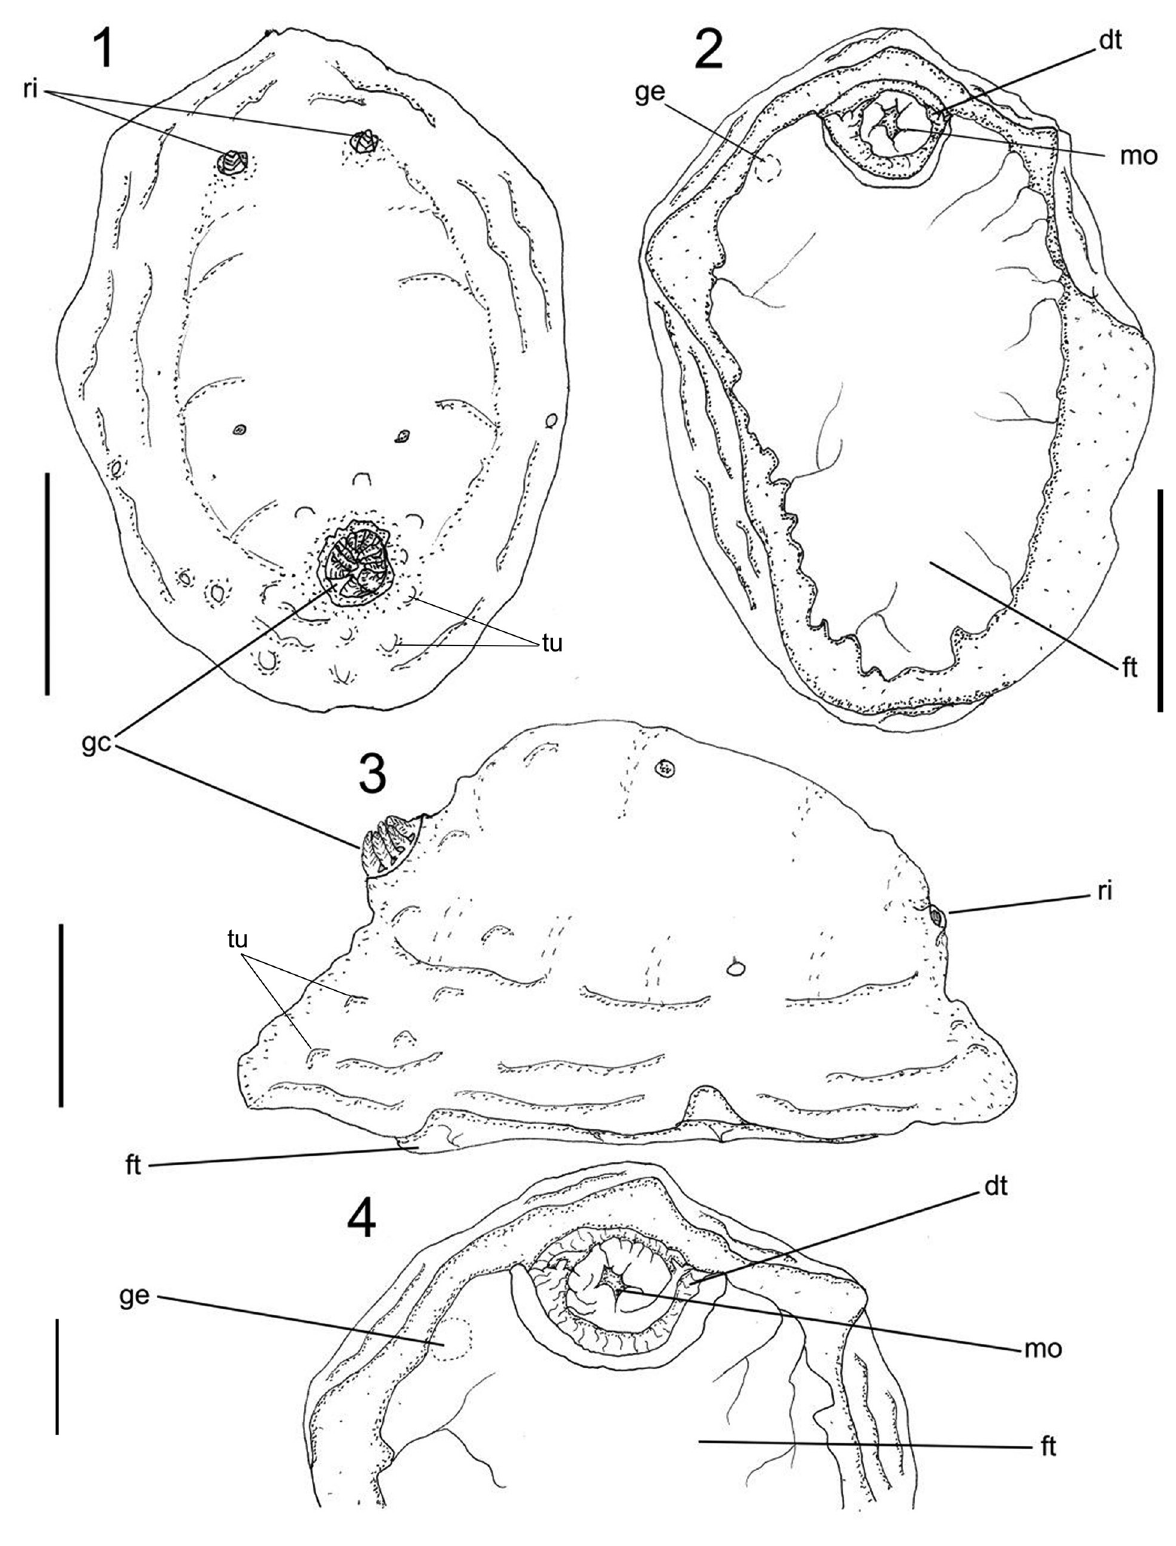
Figures 1–4. External morphology of Actinocyclus verrucosus. 1. Whole dorsal view, scale: 5 mm. 2. Whole ventral view, scale: 5 mm. 3. Whole right lateral view, scale: 5 mm. 4. Detail of anterior border of foot, ventral view, scale: 2